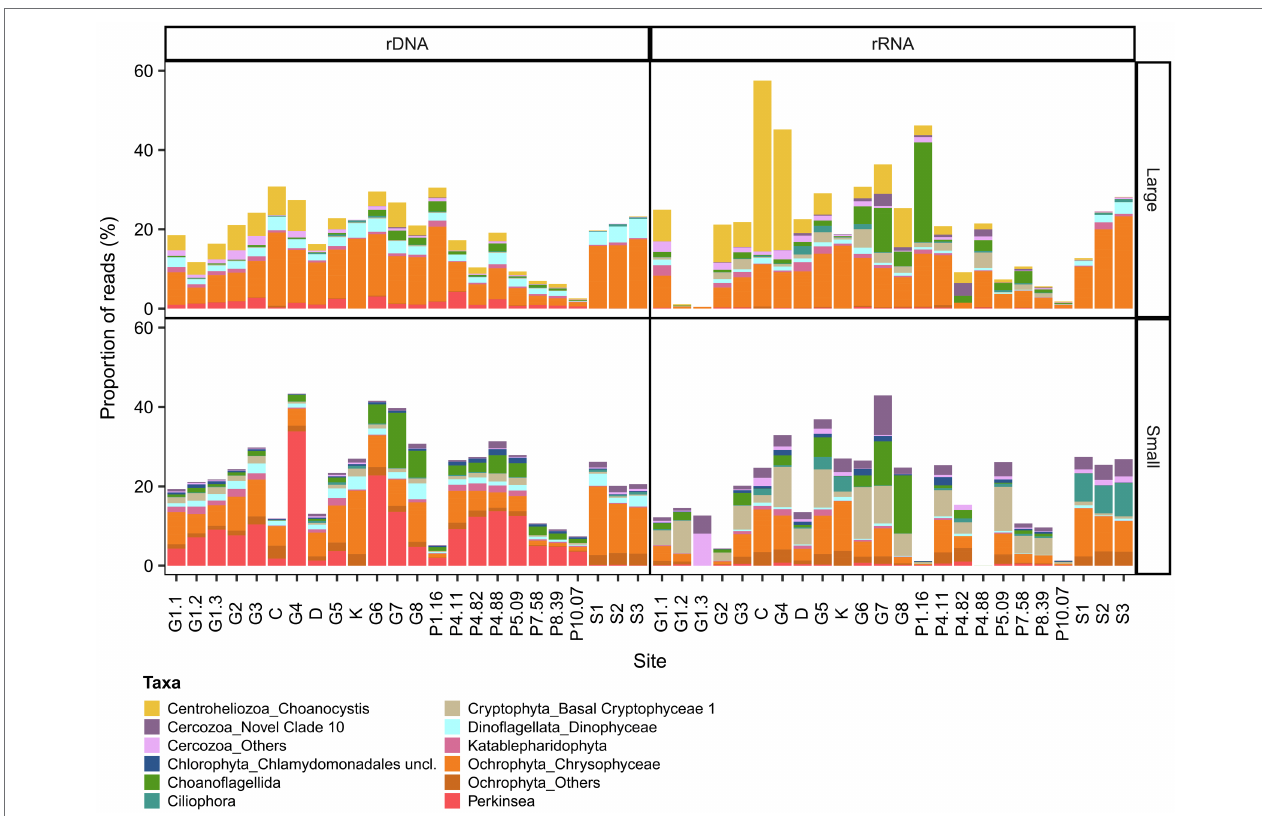
FIGURE 5 | Eukaryotic composition of the core microbiome in GWR and associated waters. The values are % reads for 18S rDNA or rRNA in the large (top) and small (bottom)